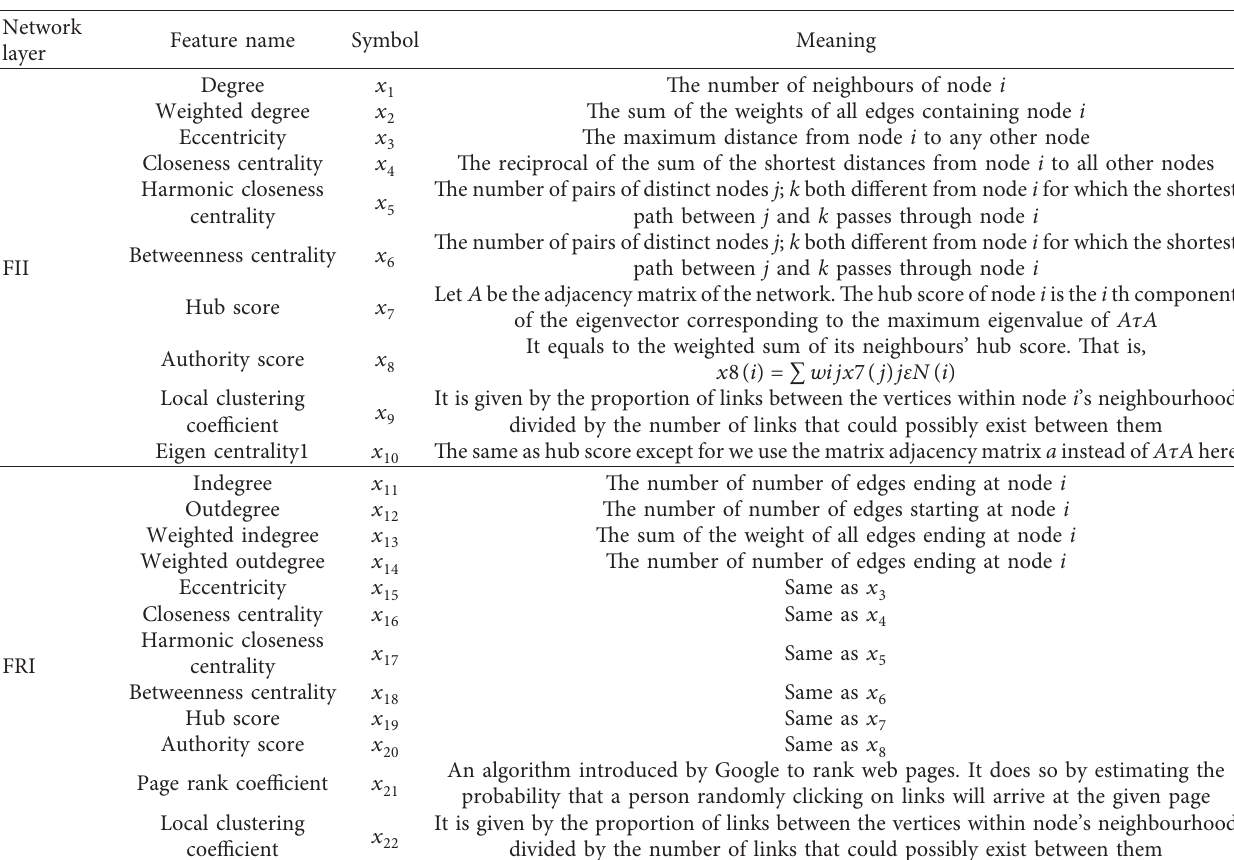
Table 5: Meaning of